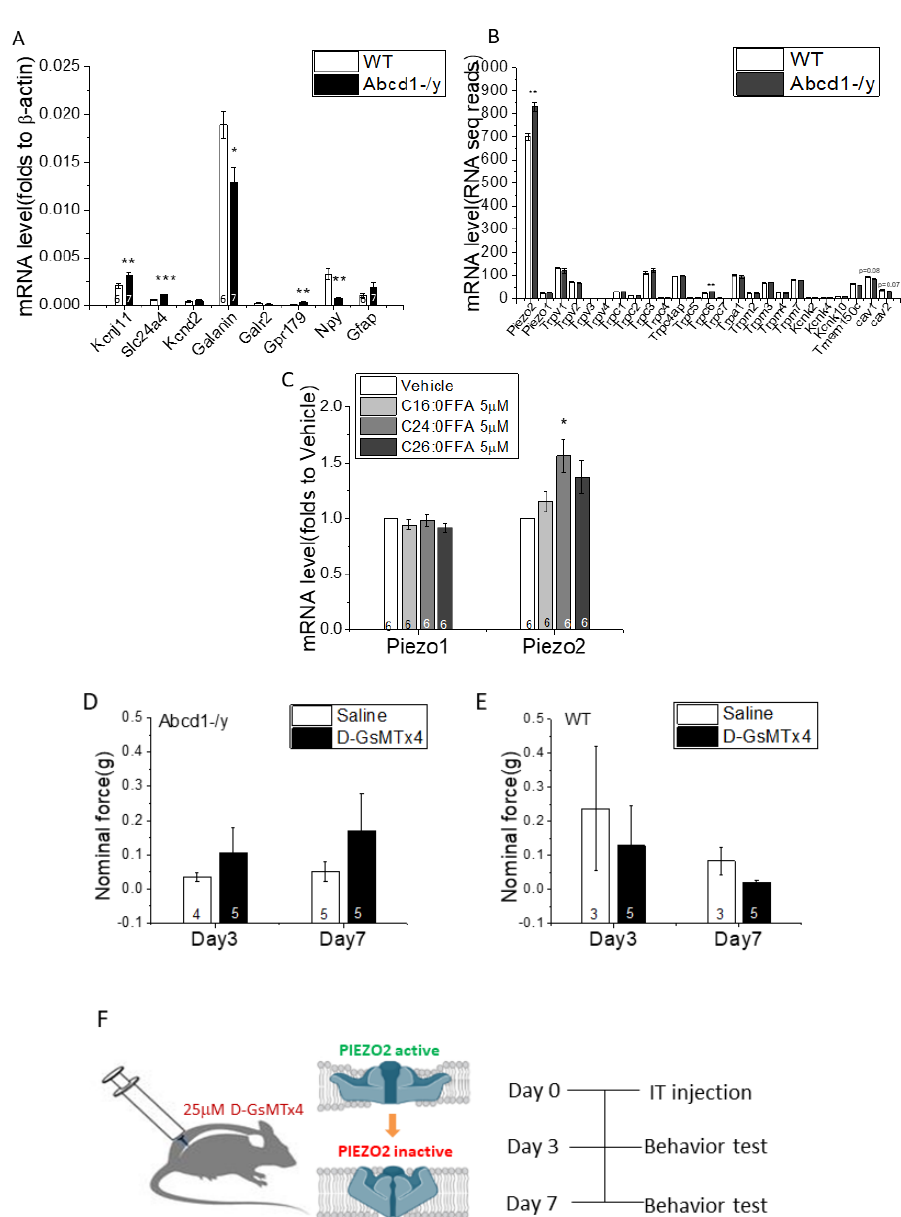
Figure 5. PIEZO2 is highly expressed in dorsal root ganglia of Abcd1 − /y mice and blocking the mechanosensitive channel partially rescues mechanical allodynia. ( A ) qPCR verification of selected genes enriched in RNA − seq that are involved in key neuronal functions (n = 6 for WT and n = 7 for Abcd1 − /y ). ( B ) Profiling of mechanosensitive channel genes and caveolin genes from RNA-seq data. ( C ) Impact of lipids upon Piezo1 and Piezo2 gene expression in differentiated rat DRG neurons. Changes in mechanical sensitivity in ( D ) Abcd1 − /y and ( E ) WT mice after intrathecal (IT) delivery of PIEZO2 blocker D-GsMTx4 (25 μ M; sensory thresholds assessed by Von Frey testing). ( F ) Schematic illustration of D-GsMTx4 blocking of PIEZO2 channels by IT delivery. Results were expressed as means ± SEM. * p < 0.05, ** p < 0.01, and *** p < 0.001 as compared with WT control.